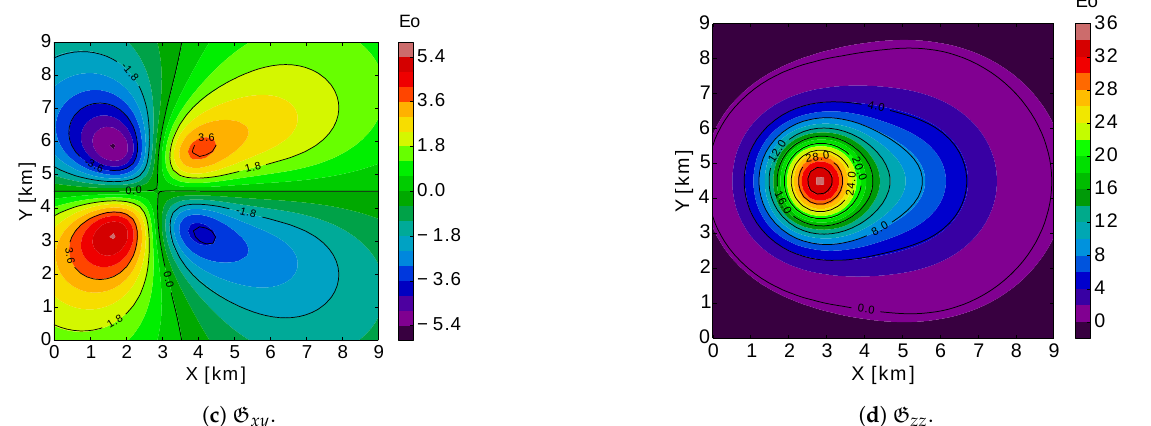
Figure 23. Initial (colour map) and inverted (contour lines) gradiometric response for the S model.